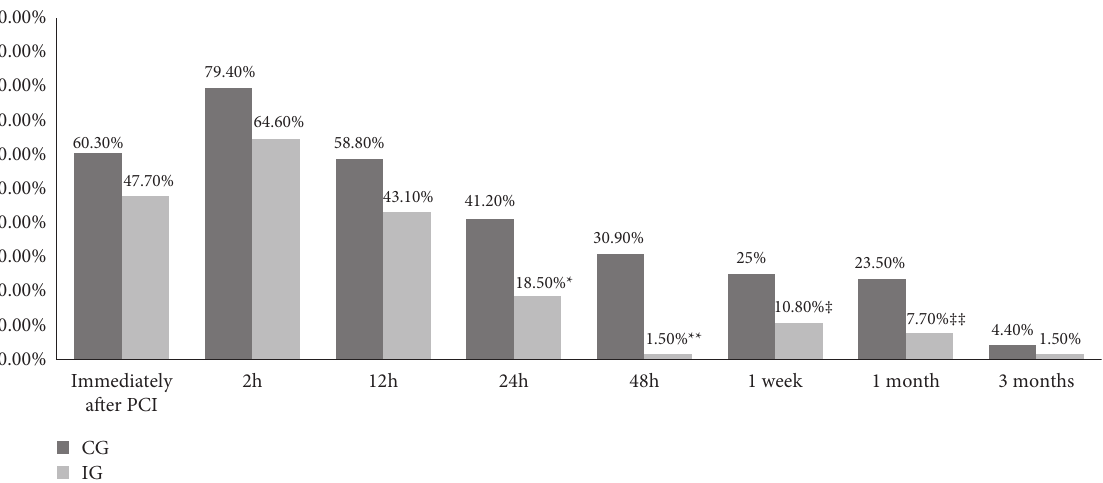
Figure 2: Access site pain prevalence during the follow-up period. PCI: percutaneous cardiac intervention; CG: control group; IG: intervention group; ∗ p � 0 . 005; ∗∗ p ≤ 0 . 001; ‡ p � 0 . 042; ‡‡ p � 0 . 017.